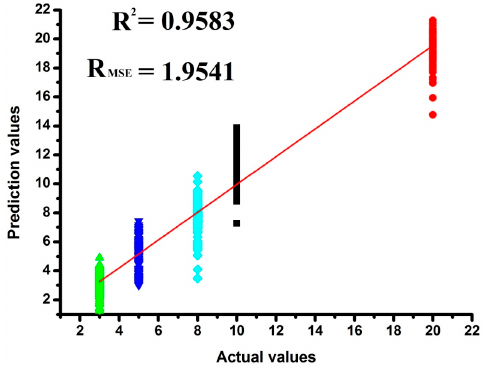
Figure 7. The prediction results for rice wines with different marked ages based on PLSR.